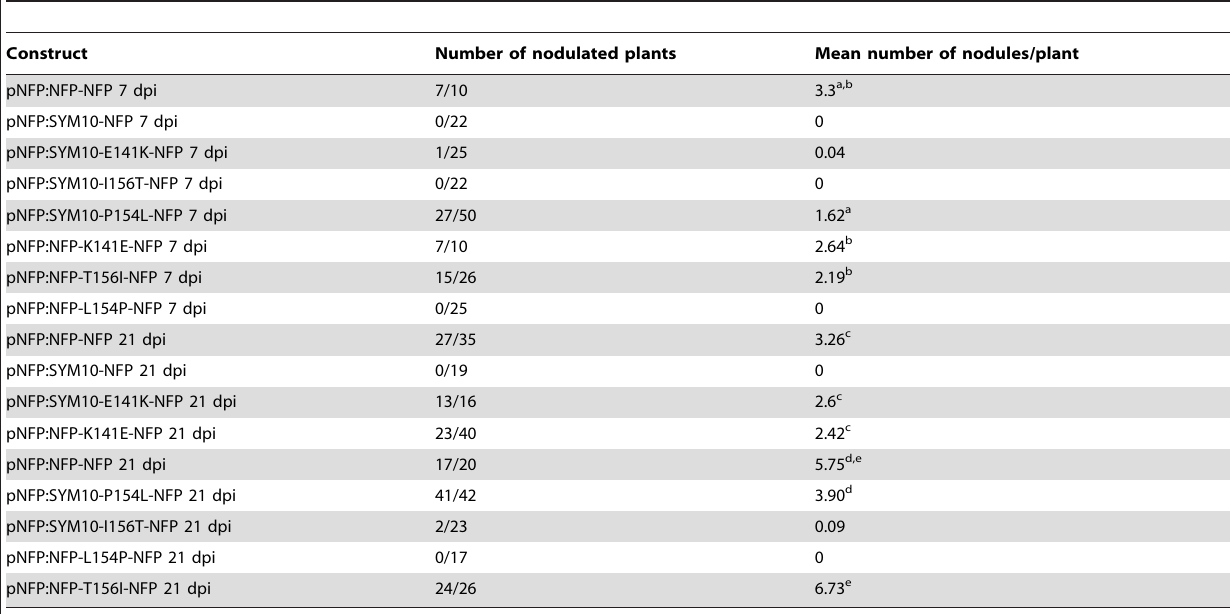
Table 2. Comparison of nodulation levels of nfp plants complemented by constructs with different point mutations either in the SYM10 ECD or NFP ECD, upon inoculation with wild type S. meliloti , at 7 dpi or 21 dpi.